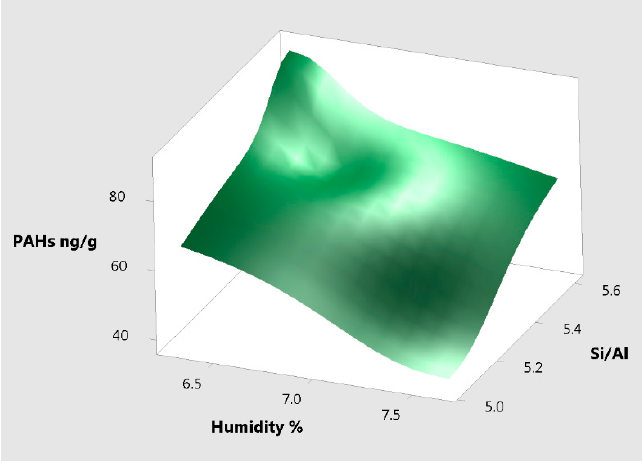
Figure 12. Surface plot of PAHs vs. Si/Al, humidity.